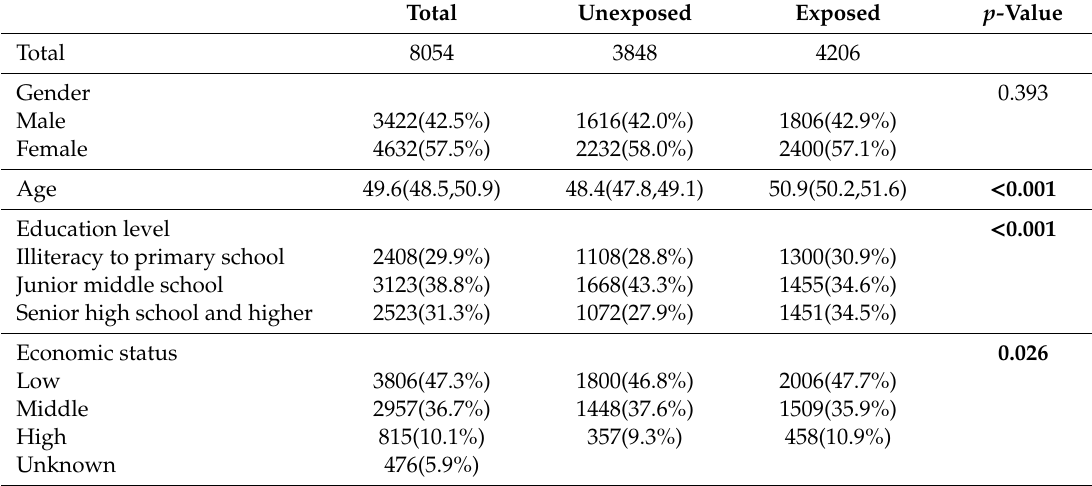
Table 1. Characteristics of the